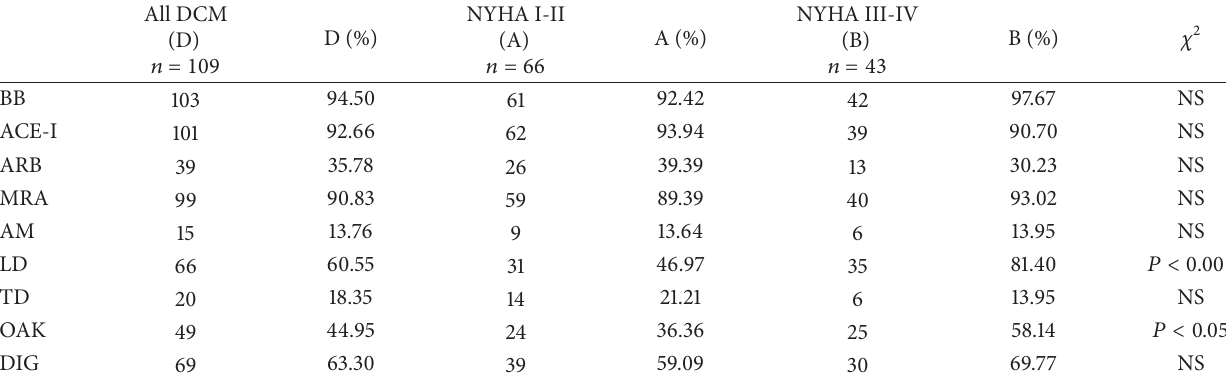
Table 1: Pharmacological treatment with division into groups depending on NYHA